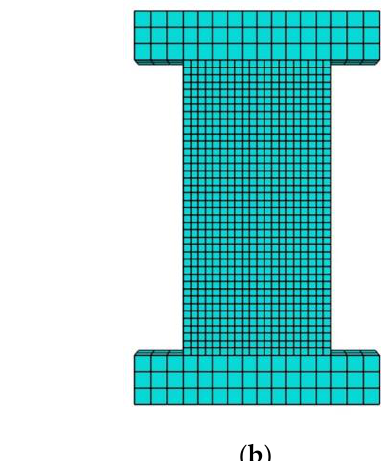
Appl. Sci. 2022 , 12 , 10622 20 of 24